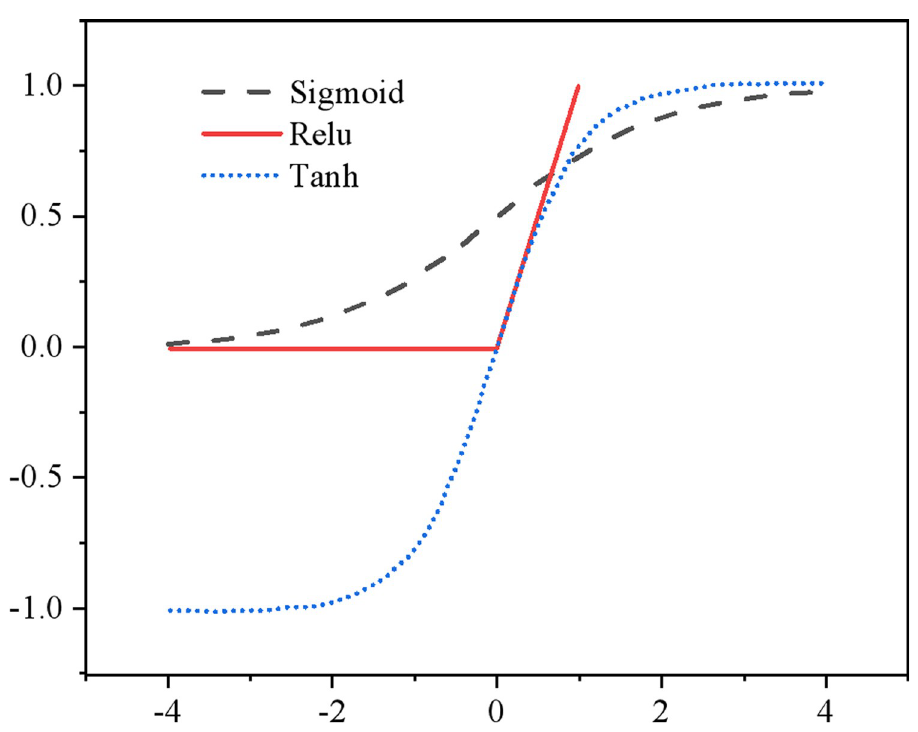
Fig 6. Curves of three activation functions.